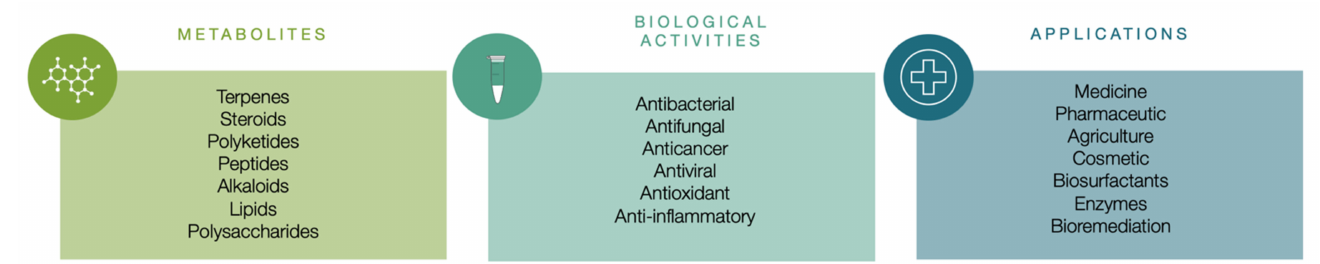
Figure 5. Diversity of metabolites’ classes produced by marine fungi and their biological activities with potential